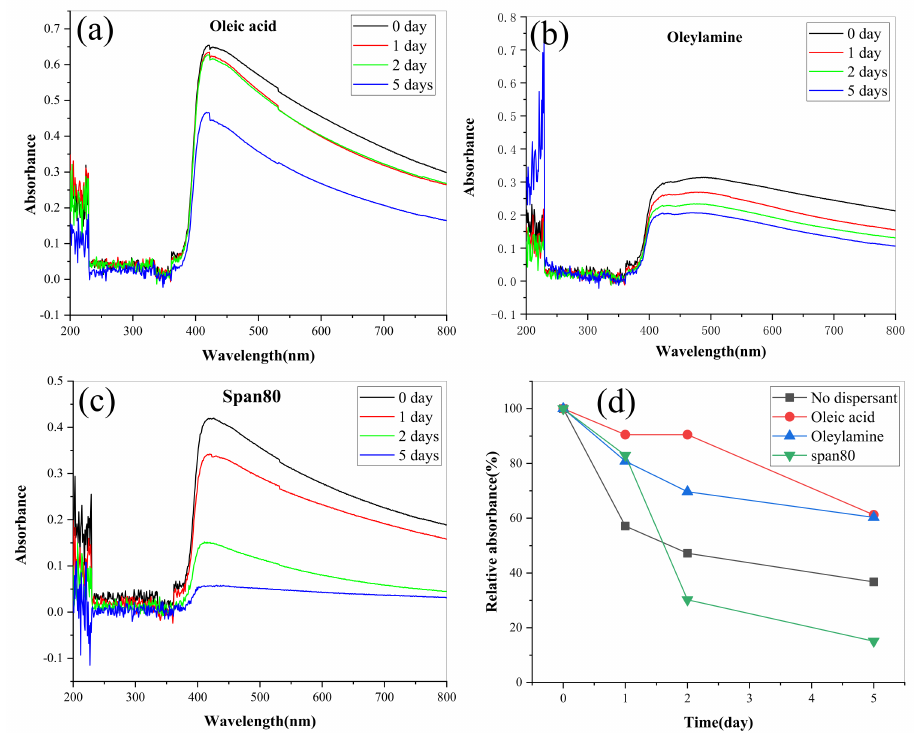
Figure 11. Variations of absorbance of LSMLO with different dispersants over time. ( a ) oleic acid; ( b ) Oleylamine; ( c ) span 80; ( d ) relative absorbance.